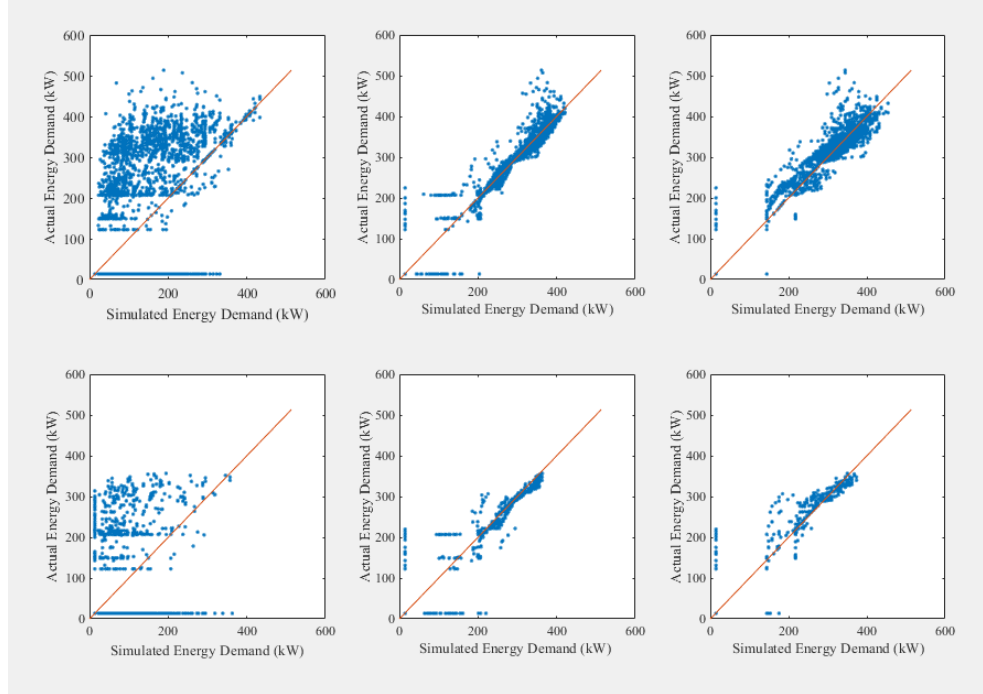
Figure 4. Training ( above ) and testing ( below ) data for the performance of Models 3,4, and 5 for Building 2.